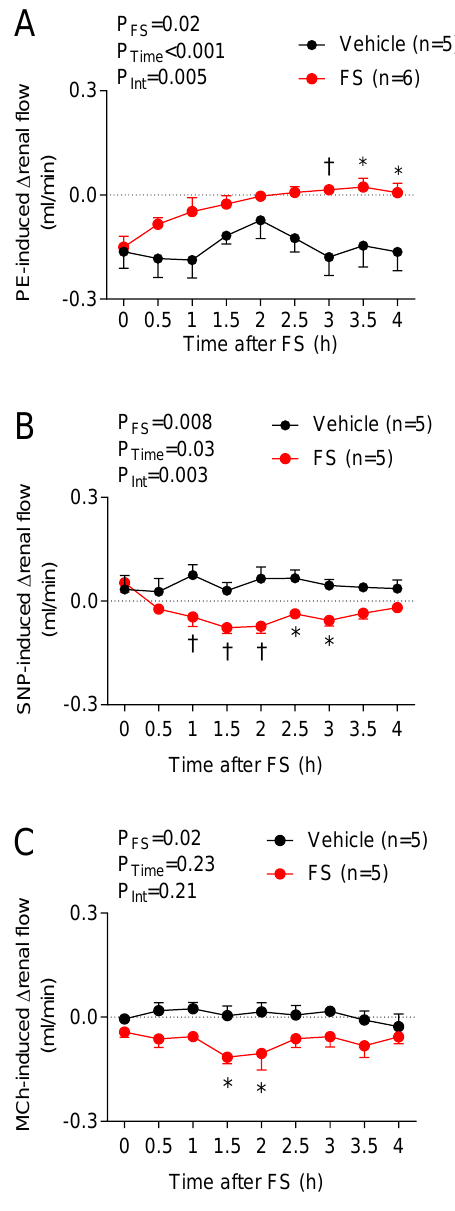
Figure 4. Fecal slurry (FS)-induced peritonitis caused progressive changes in renal blood flow responses to repeat administration of bolus doses of ( A ) phenylephrine (PE), ( B ) sodium nitroprusside (SNP), and ( C ) methylcholine (MCh) over time in mice. Data were analyzed by two-way ANOVA for the effects of FS and time, followed by the Holm–Sidak post hoc test for multiple comparisons. * p < 0.05 and † p < 0.01 compared with the vehicle at the same time.